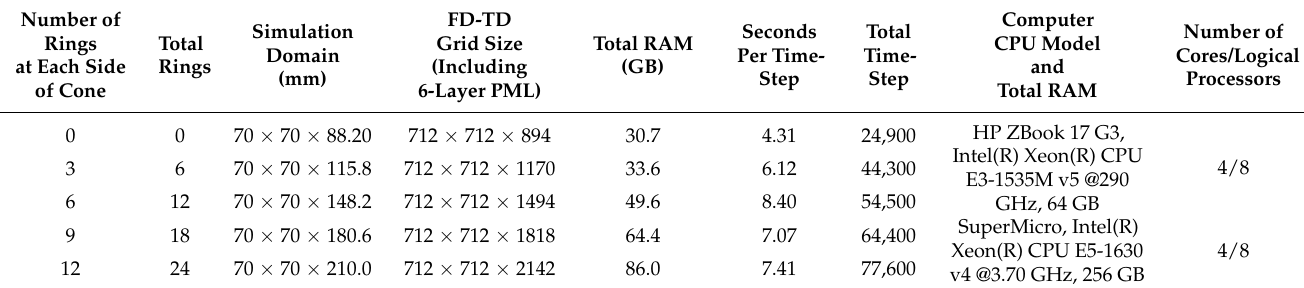
Figure 20. The radiation patterns of 24-ring-loaded MBA at middle-frequency points of six bands with VSWR ≤ 2 in Table 1. Table 2. Information of computational time, costs and used resources.